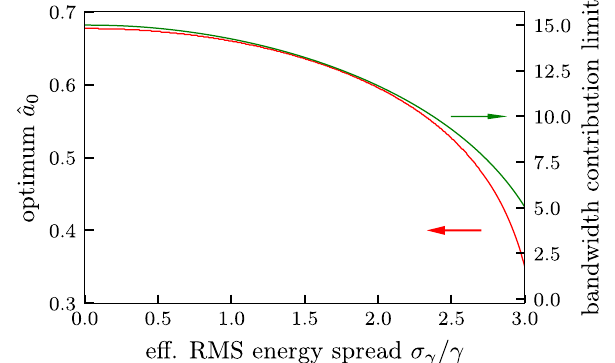
FIG. 7. Optimum ˆ a 0 as a function of the bunch energy spread.